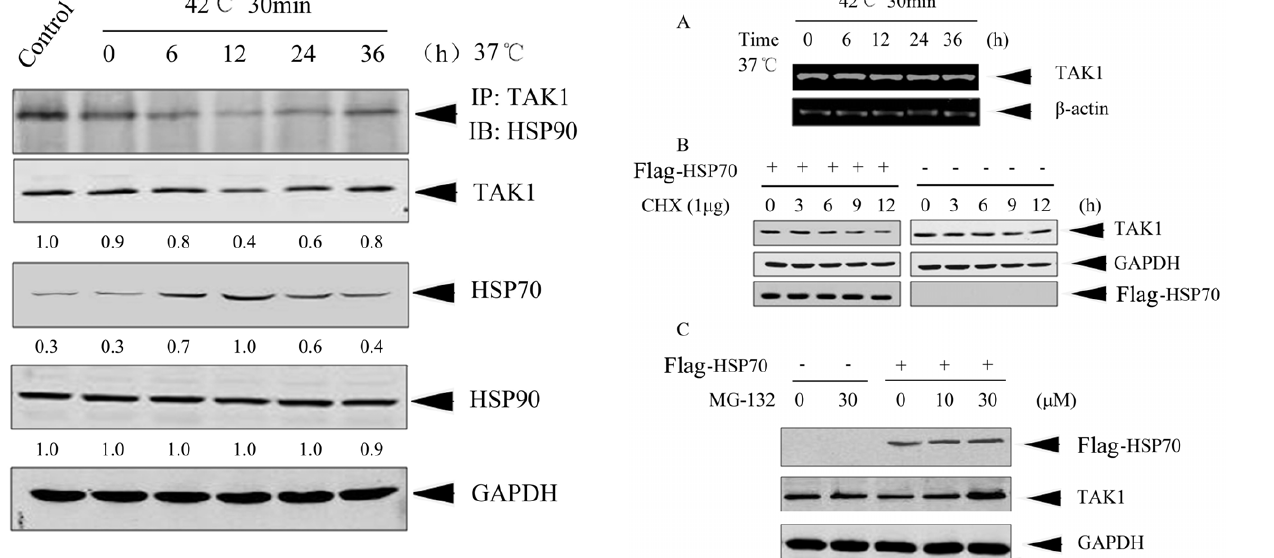
Figure 2. Increased expression level of HSP70 upon heat shock reduced TAK1 protein level and the association between HSP90 and TAK1. HeLa cells were either untreated (control) or exposed to a mild heat shock (42 u C for 30 min) followed by recovery at 37 u C for indicated time periods. Cell lysates were prepared and subjected to immunoblotting with indicated antibodies or immuno- precipitation with TAK1 antibody. The immunopellets were analyzed by immunoblotting with HSP90 antibody. Equal loading protein was confirmed by GAPDH. The numbers below each Western blot represent relative expression level normalized to GAPDH, which were determined based on the intensity of band. These experiments were independently repeated for three times, and the representative blots were shown.